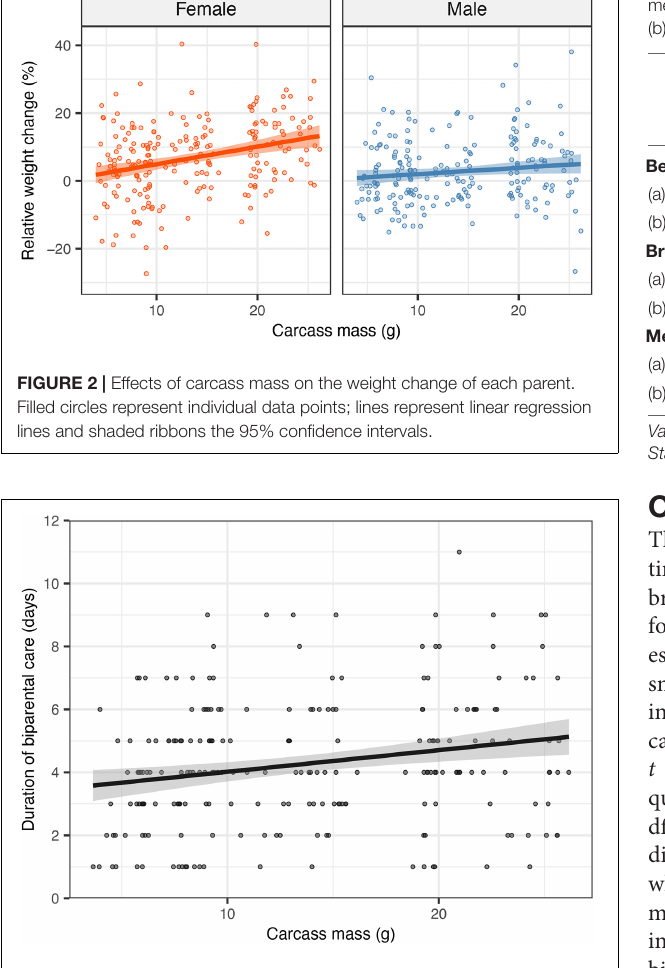
FIGURE 3 | Effects of carcass mass on the duration of biparental care. Filled circles represent individual data point, the line represents linear regression lines and shaded ribbons the 95% confidence intervals.